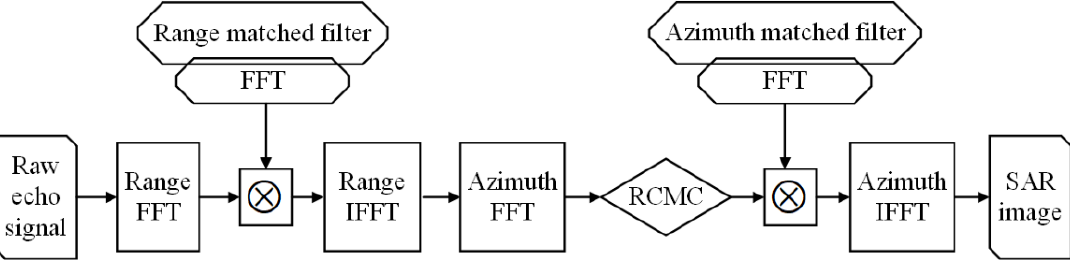
Figure 9. Flow of RD imaging processing.